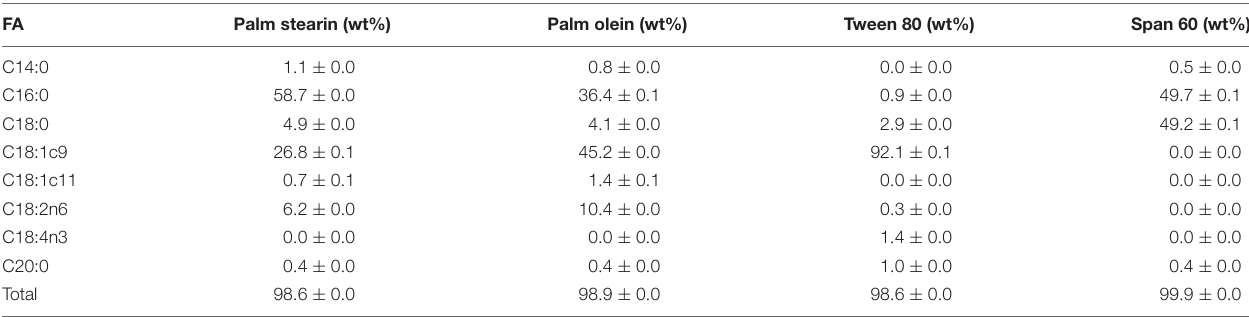
TABLE 2 | Composition and properties of 20% oil-in-water emulsions. 1 , 2